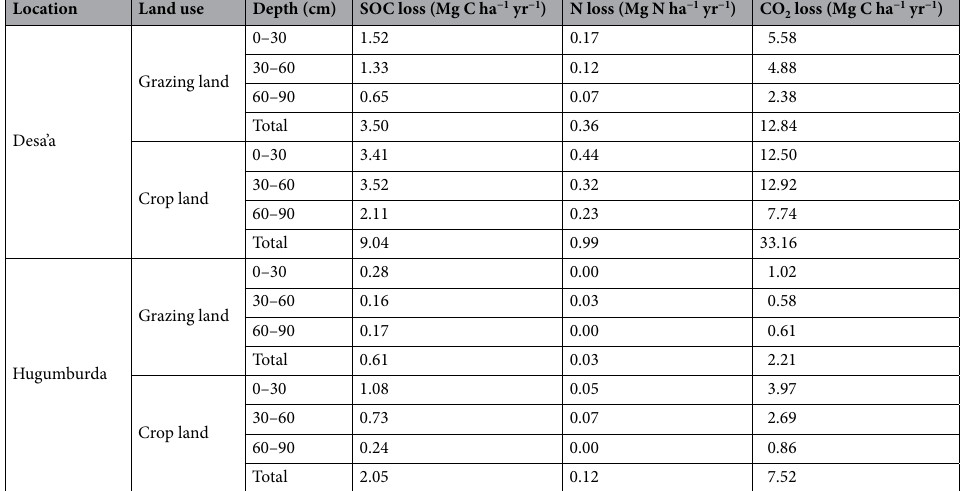
Table 4. Soil carbon and nitrogen loss and calculated potential carbon dioxide emission related to a change in land use (conversion from forest [baseline] to grazing and cropland) in Desa’a and Hugumburda.